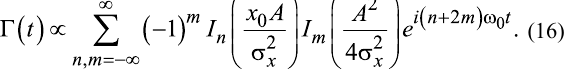
creasing the oscillation amplitude further A = 200 μ m ≈ 9 σ x , more and more higher harmonics appear (Figure